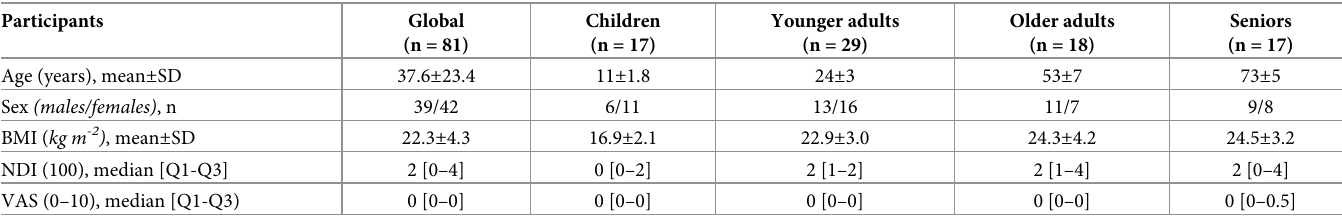
Table 1. Characteristics of the participants according to the four age